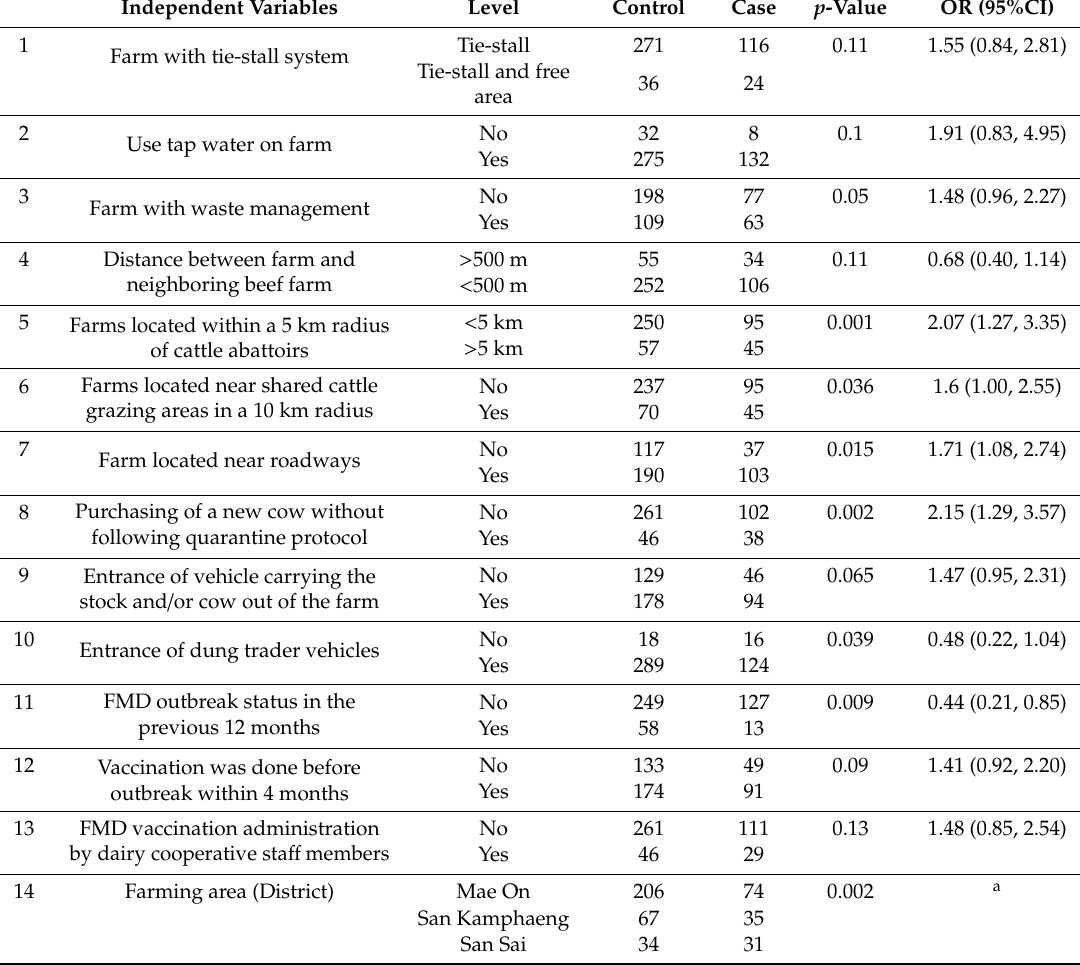
Table 2. Variables with FMD outbreaks based on univariable logistic regression analysis ( p < 0.2). Independent Variables